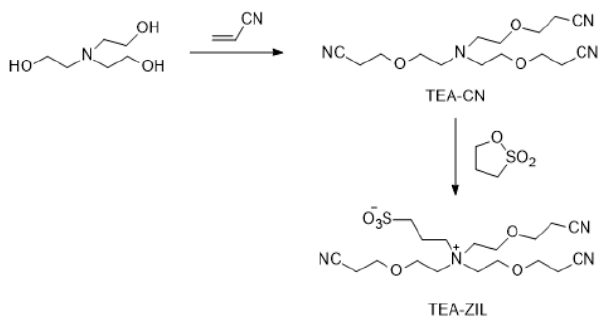
Figure 10. Synthesis of TEA-ZIL.